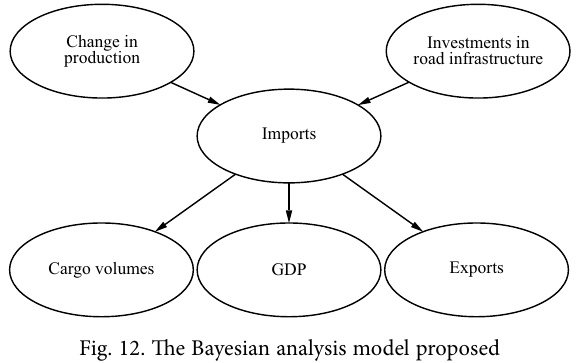
Fig. 12. The Bayesian analysis model proposed